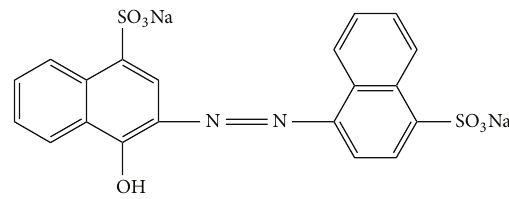
Figure 1: Chemical structure of AR